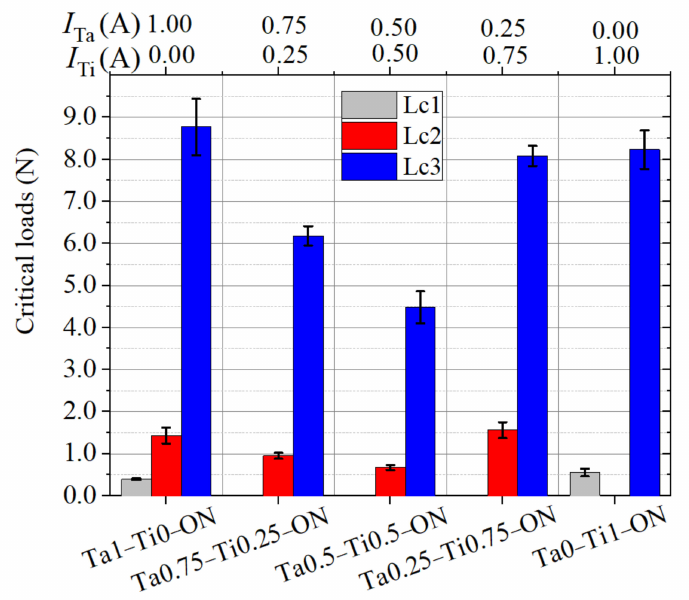
Figure 6. The variation of the scratch test adhesion critical loads: Lc 1—first cracks; Lc 2—first delamination; Lc 3—total film